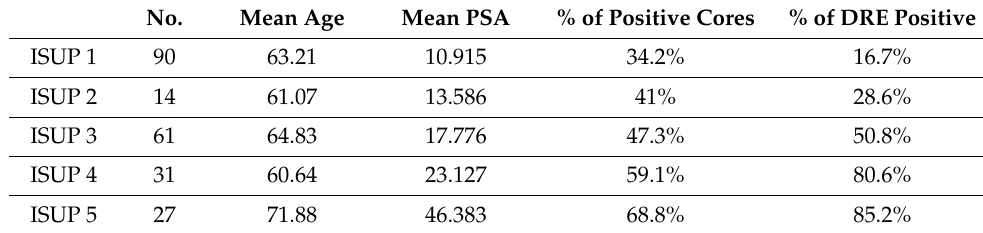
Table 2. Correlations between the ISUP grading and different patient parameters.